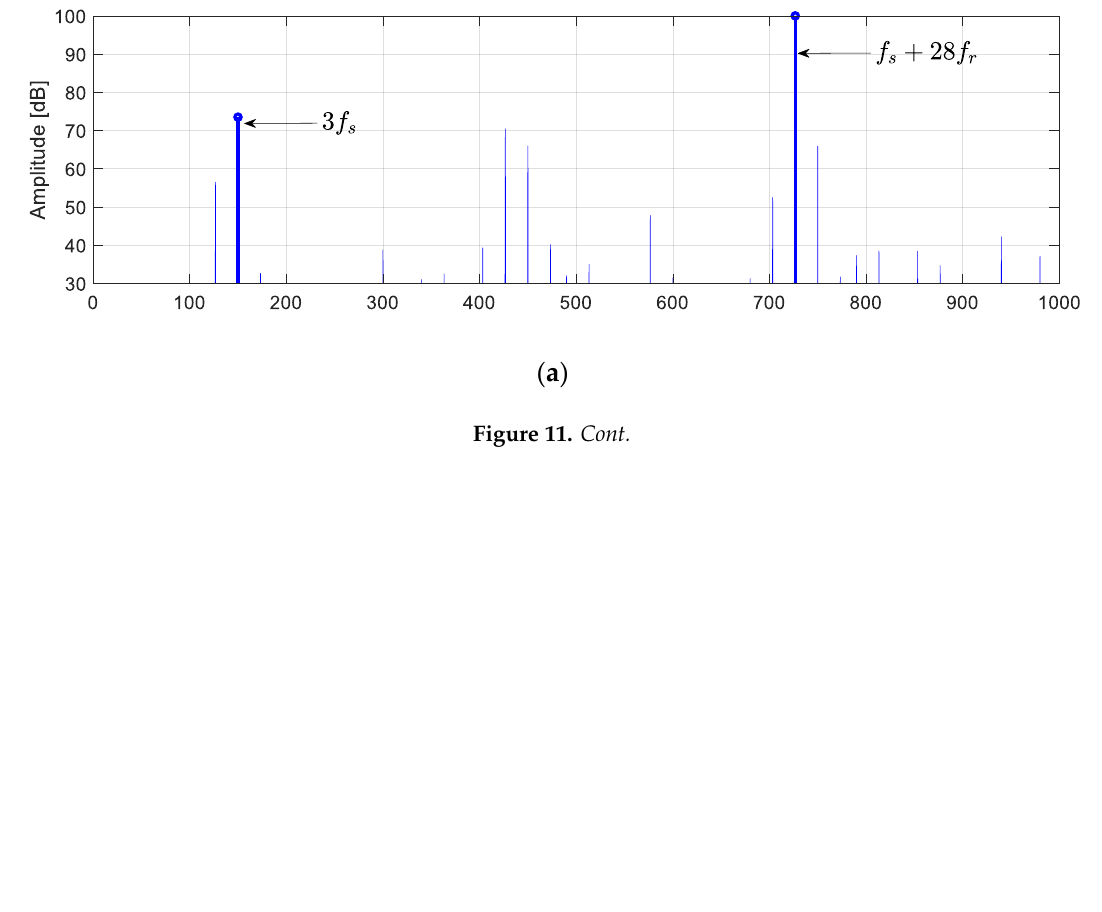
15 of 26 Figure 9. Electric circuit model in the FEM software, the B-H curve, the stator, and rotor slots’ dimensions : ( a ) stator winding connection to supply the voltage and measurement equipment in the Maxwell Circuit Editor ; ( b ) B-H curve of the M19 steel sheet; ( c ) stator slot, where: